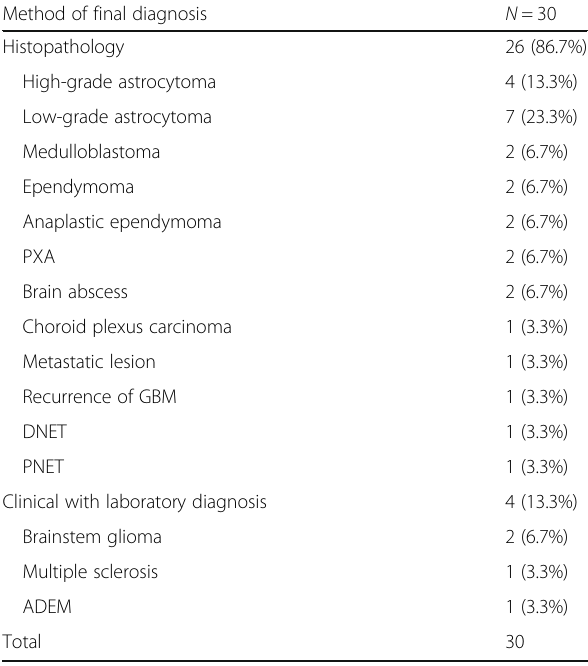
Table 1 Distribution of final diagnosis among studied patients based on pathological diagnosis or clinical-laboratory diagnosis and follow-up imaging